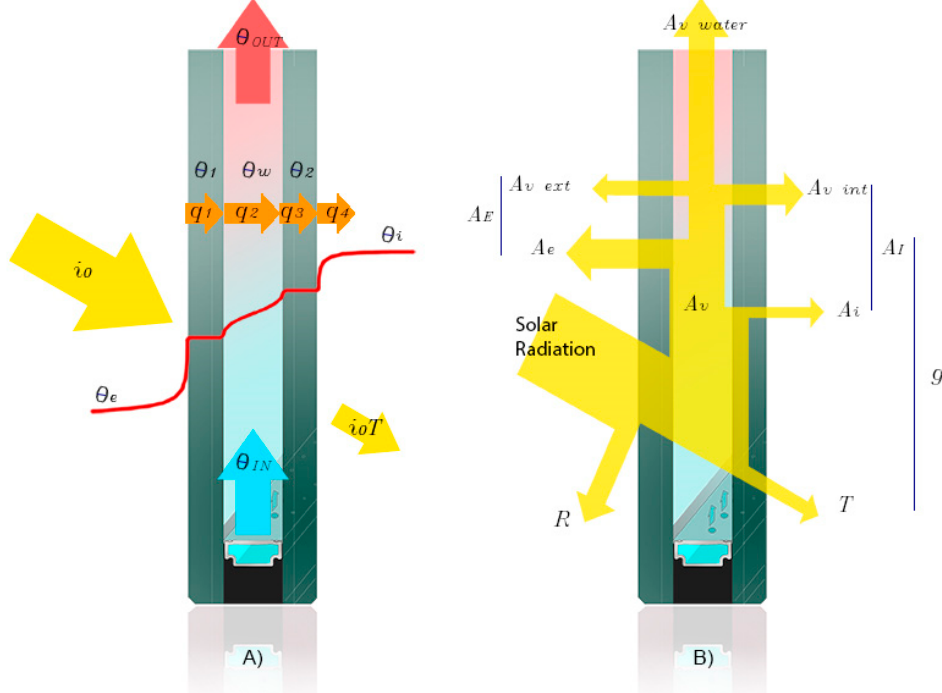
Figure 3. ( A ) Temperature distribution in a WFG and description of heat fluxes and temperatures of layers at a specific height of the envelope. ( B ) Distribution of solar radiation on the glazing. It is divided into the reflectance ( R ), the energy transmittance ( T ), the constant part of the secondary external and internal heat transfer factor ( A e and A i respectively), and the net absorptance of the water ( A v ).